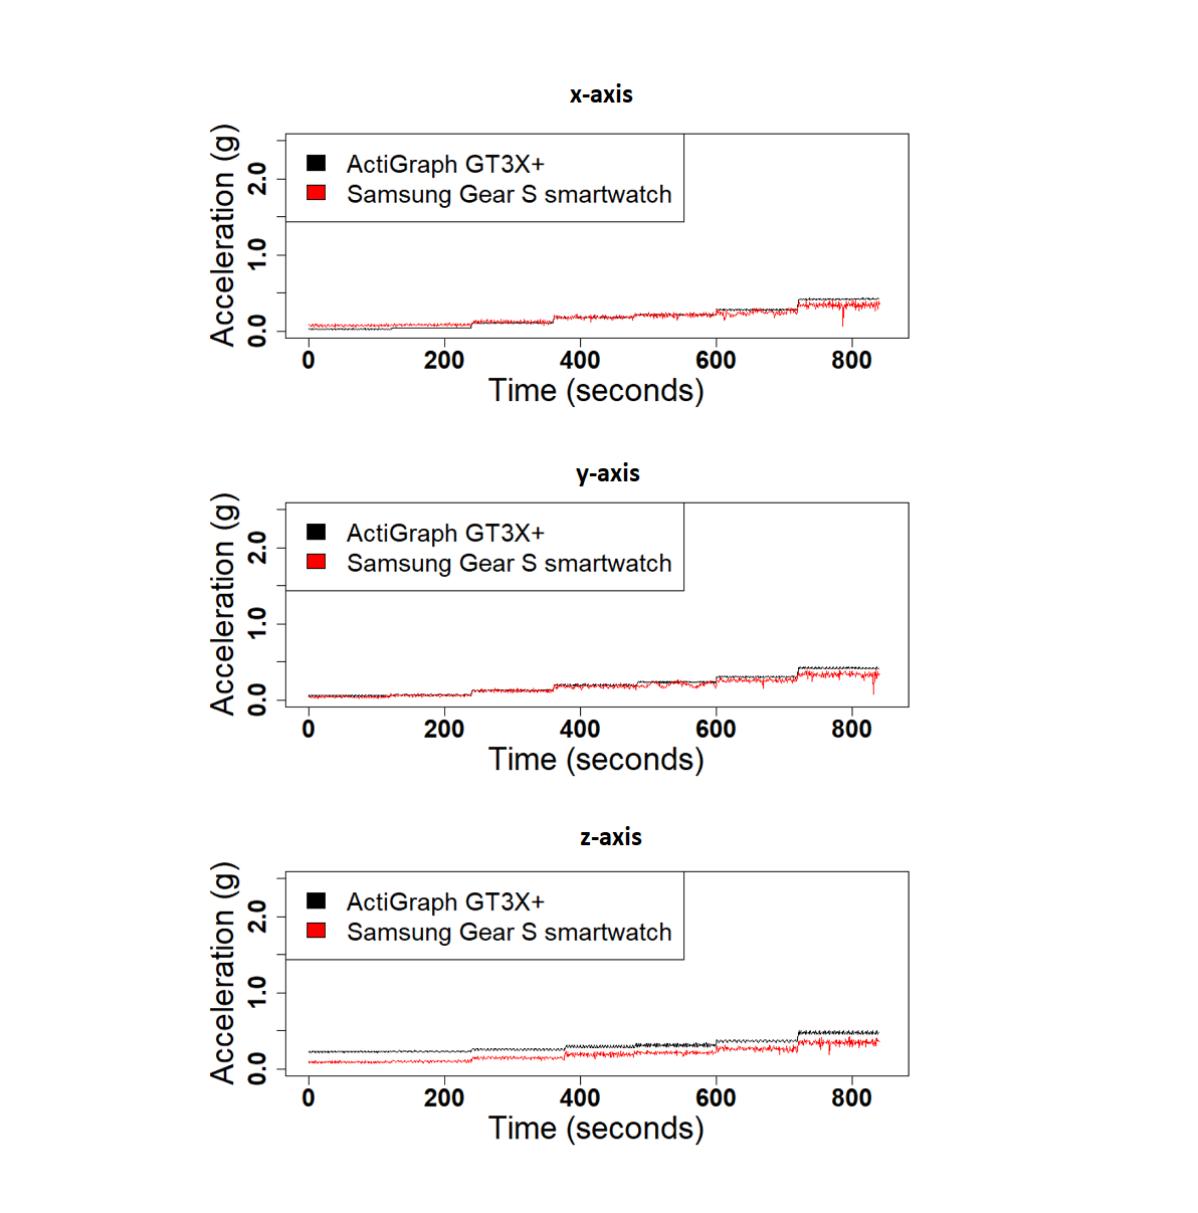
Figure 4. The 1-second root mean square of the acceleration data from Samsung Gear S smartwatch and ActiGraph GT3X+ for each axis for the shaker